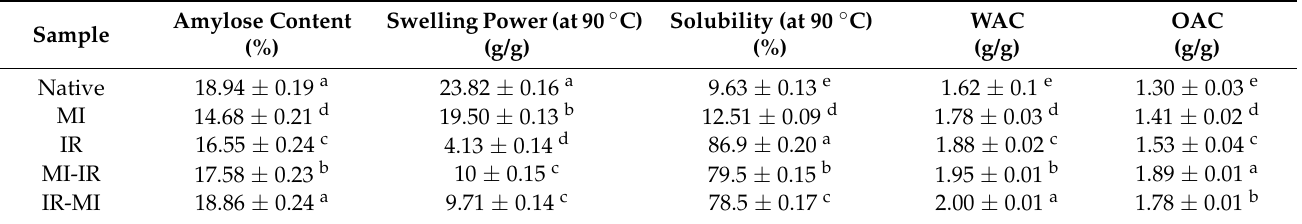
Table 1. Amylose content, swelling power, and solubility of native and modified lotus rhi- zome